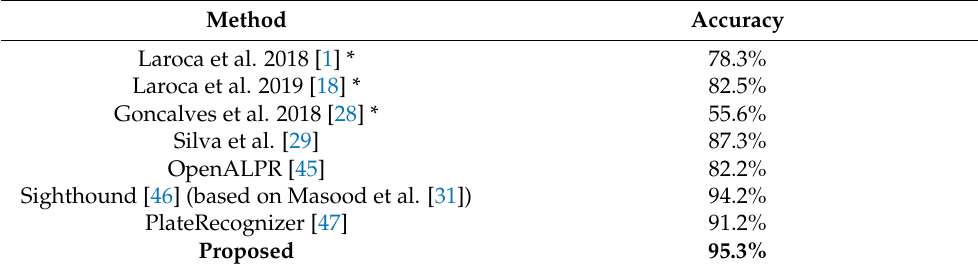
Table 4. Comparison of the proposed mobile ALPR system with the existing methods, using the UFPR benchmark dataset [1].